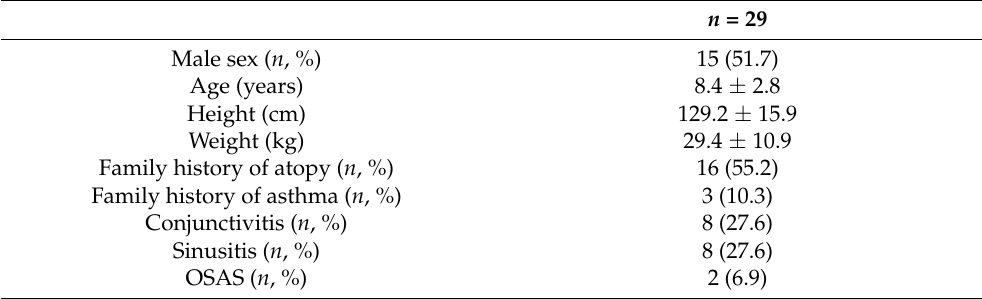
Table 1. Anthropometric characteristics and comorbidities of the study